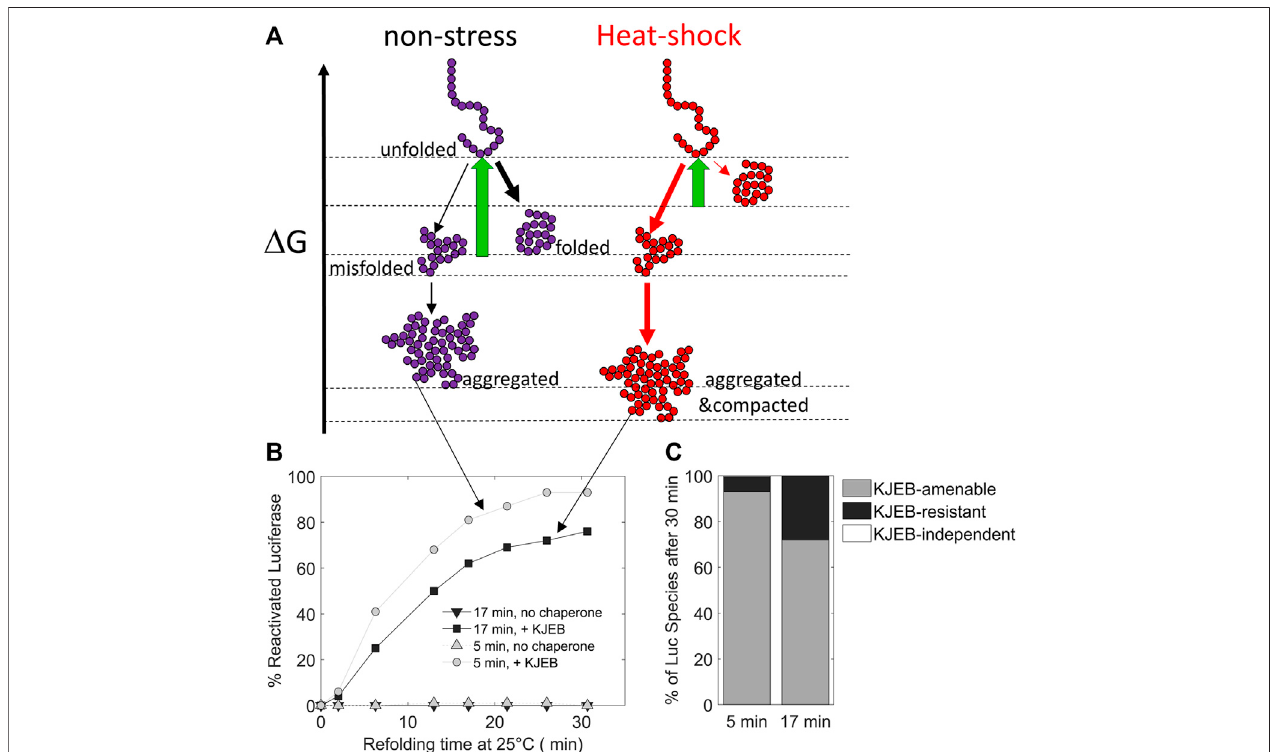
FIGURE 3 | The duration of the heat-stress may change the position of protein conformers on a free energy scale. (A) free-energy diagram showing the various folding states of a polypeptide under non-stress (left) and heat-shock conditions (right, red). (B) time-dependent refolding of heat pre-denatured fi re fl y luciferase (gray curves: 5 min denaturation at 45 ° C, black curves: 17 min at 45 ° C) in the presence or absence of DnaK, DnaJ, GrpE and ClpB (KJEB) at 25 ° C and ATP. (C) Deduced fraction ofchaperone-amenable,chaperone-resistant and chaperone-independent luciferase species, determined after 30 min of refolding with KJEB at 25 ° Cand ATP. Data from Goloubinoff (unpublished), based on similar experiments from (Diamant et al., 2000) and (Sharma et al.,